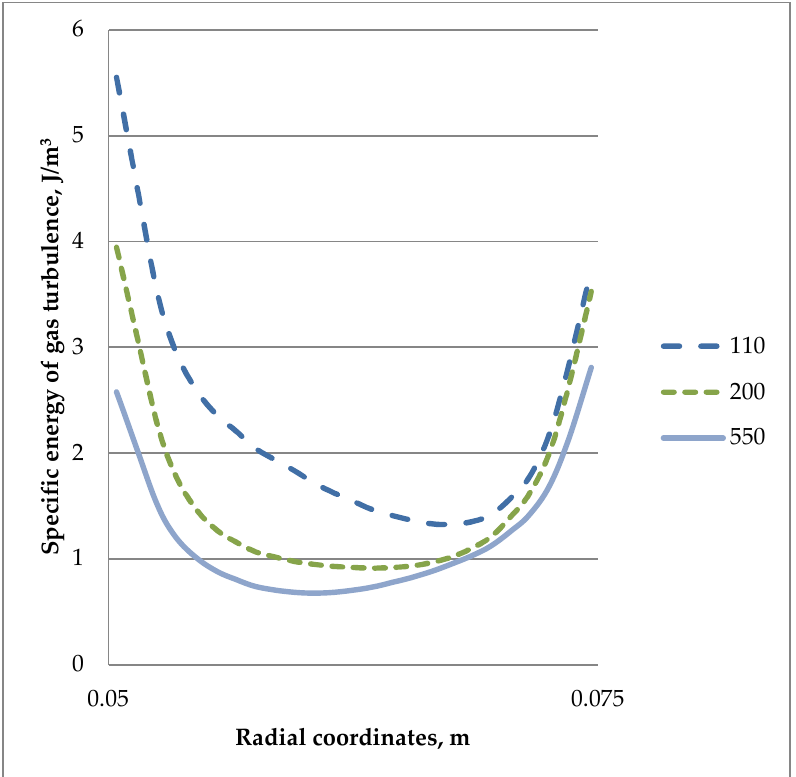
Figure 3. Specific energy distribution of gas turbulence in the chamber’s cross section: chamber diameter 150 mm; stabilizer diameter 100 mm.